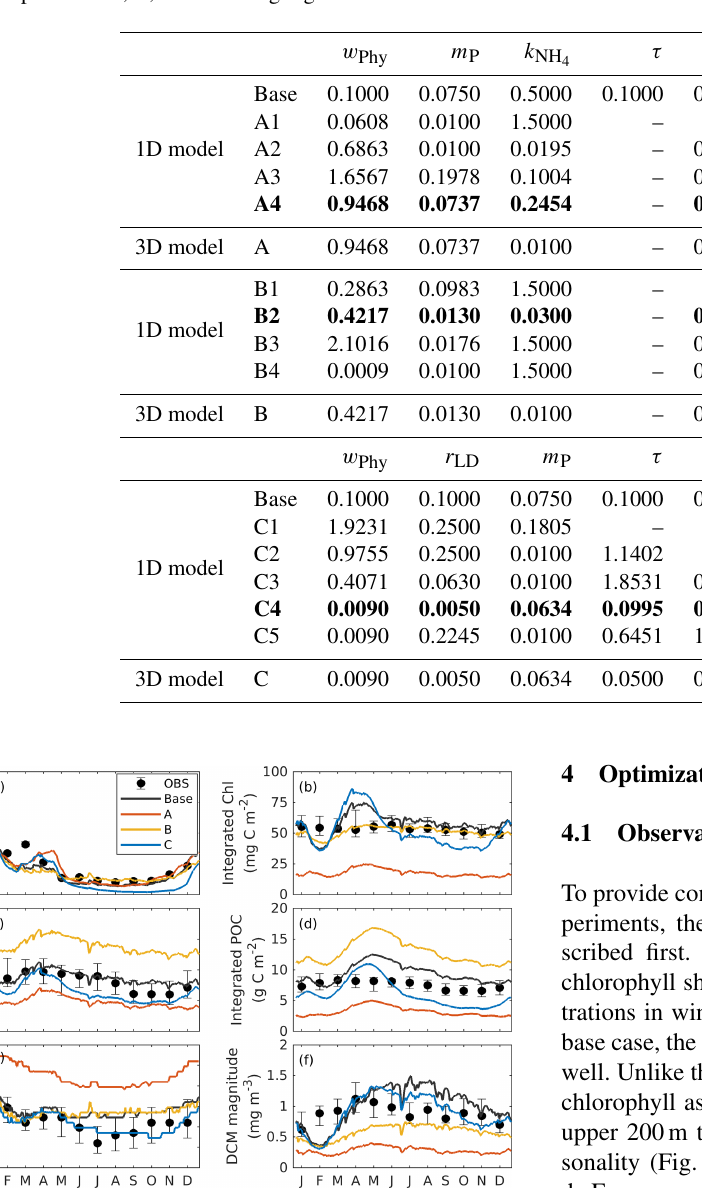
Table 2. The best fit of parameter set for each optimization experiment. Dashed lines represent that these parameters are not included in the parameter optimization and use their prior values. The optimal optimization A4, B2, and C4 which are further discussed and are denoted simply as experiment A, B, and C are highlighted as bold.